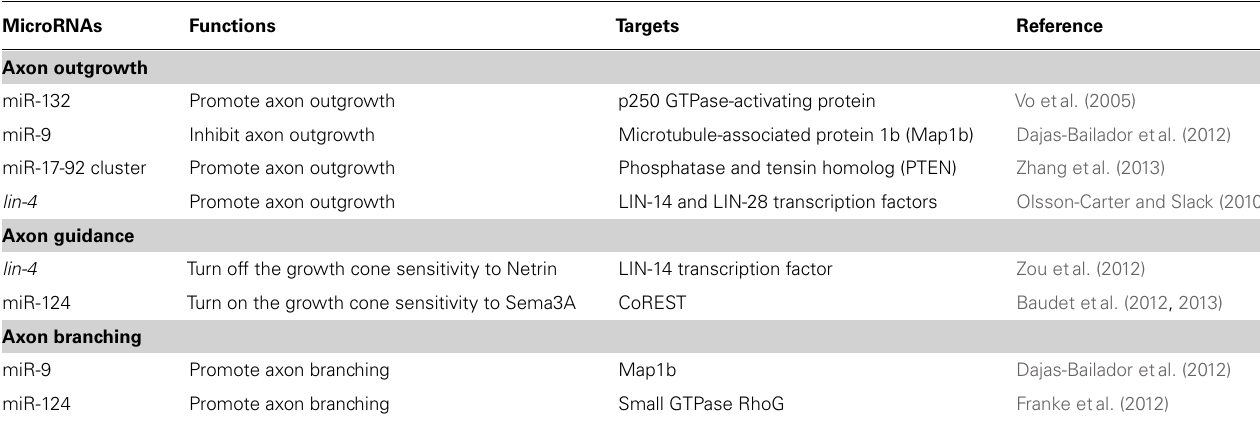
Table 1 | Summary of miRNA functions in axon development.